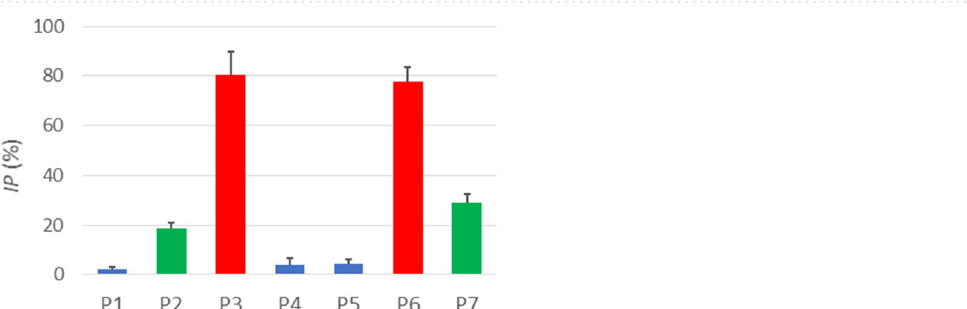
Figure 6. ThT fluorescence spectra of 35 μM Aβ 1–42 plus 70 μM P1 ( a ), P2 ( b ), P3 ( c ) P4 ( d ), P5 ( e ), P6 ( f ), and P7 ( g ) with excitation at 435 nm, at 25 °C. Time of incubation in buffer (25 mM NaCl, 25 mM Na,K-phosphate, pH 7.2) with constant stirring by a tube rotator is indicated in panel ( a ). Vertical axes are standardized for better comparison of relative fluorescence intensities. Panel ( h ) shows the time dependence of ThT fluorescence averaged between 475 and 485 nm. Average data from three independent experiments. Error bars are shown only for P1, P3, P6, P7 to maintain clarity. Error bars for P2, P4, and P5 are of similar magnitude as for those of P1 and P7.